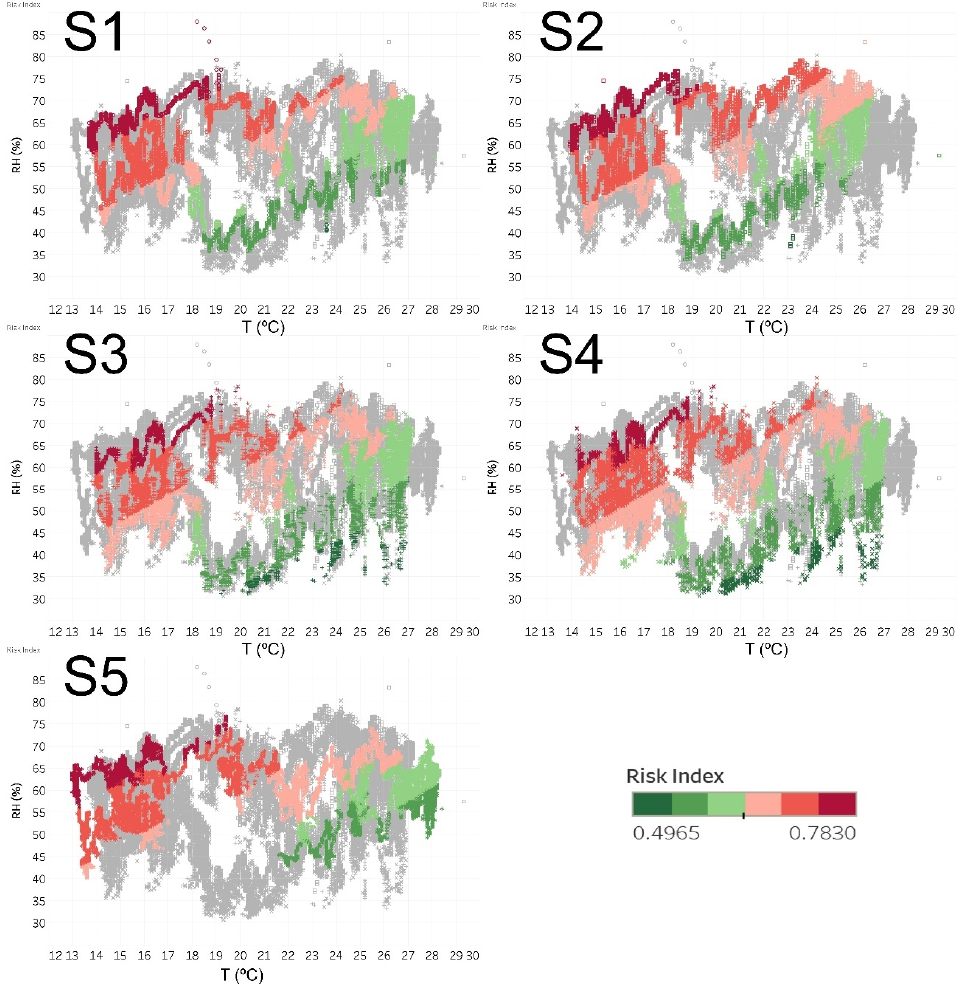
Figure 6. Comparison of the Risk index for each sensor (colour scale) on the Temperature–Relative Humidity graph.